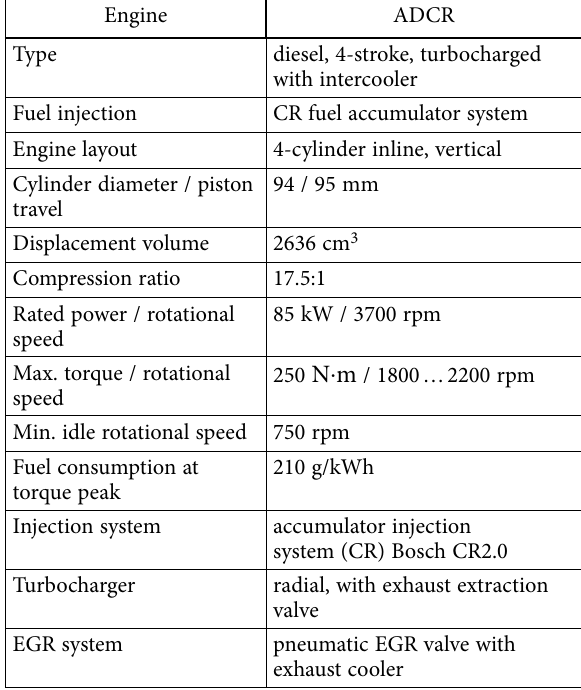
Table 3. Technical data of the ACDR engine by Andoria Motor Company